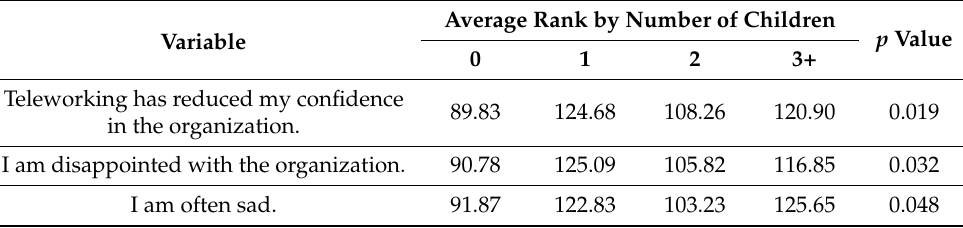
Table 9. Occupational cynicism and commitment to work by number of children in the family. Variable